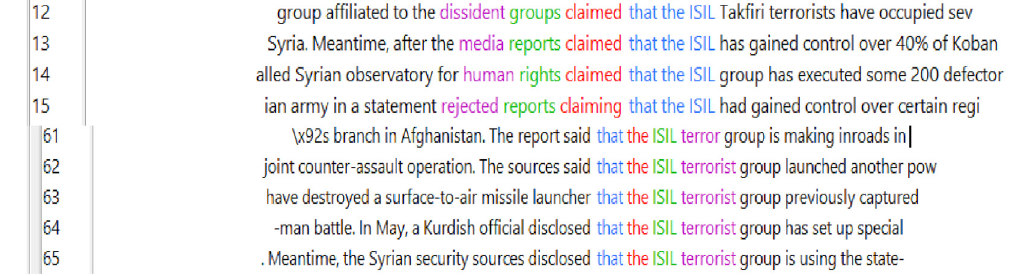
Figure 7: Concordances of that the